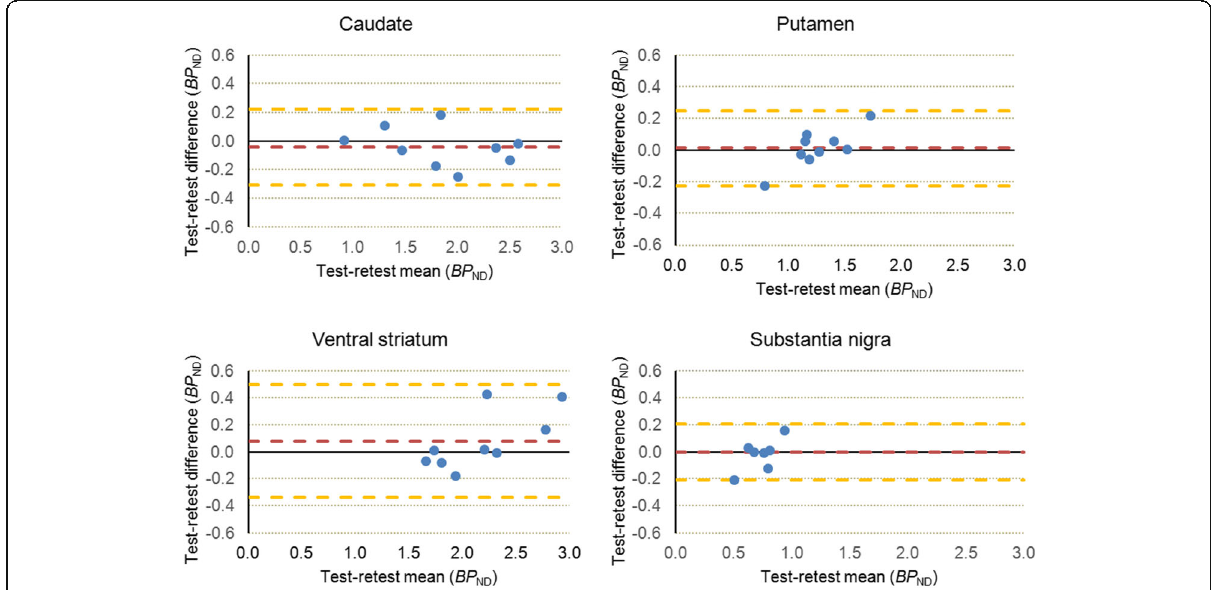
Fig. 3 Bland-Altman plots of main regions of interest. The yellow lines correspond to the upper and lower 2SD line; red line: